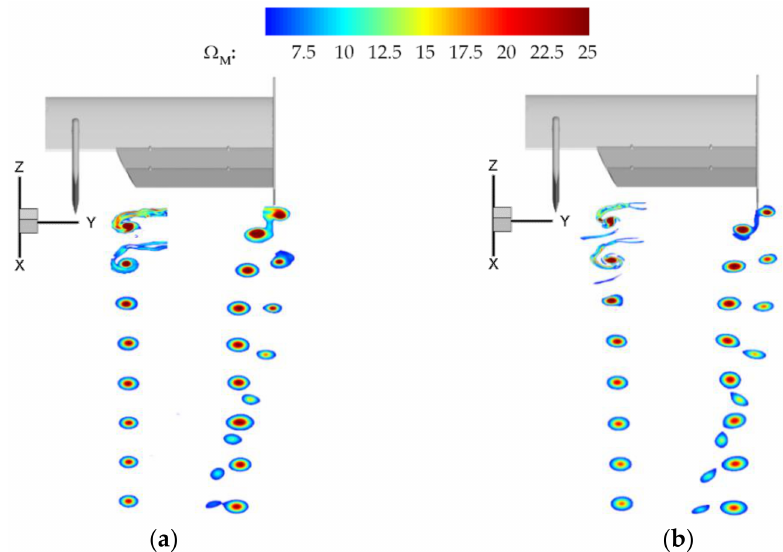
Figure 15. Contours showing the mean vorticity magnitude at several transverse locations ranging from x Wi /c e = 1.204 and x Wi /c e = 3.796. ( a ) Experiment; ( b ) Numerical solution.